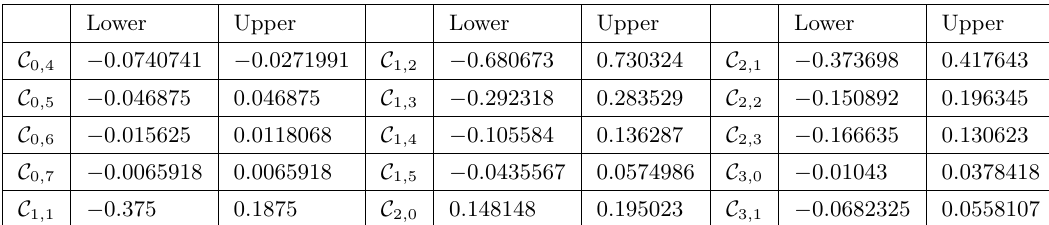
which p,q b W ( k ) p,q in table 2 p,q → b W ( k ) 1 , 0